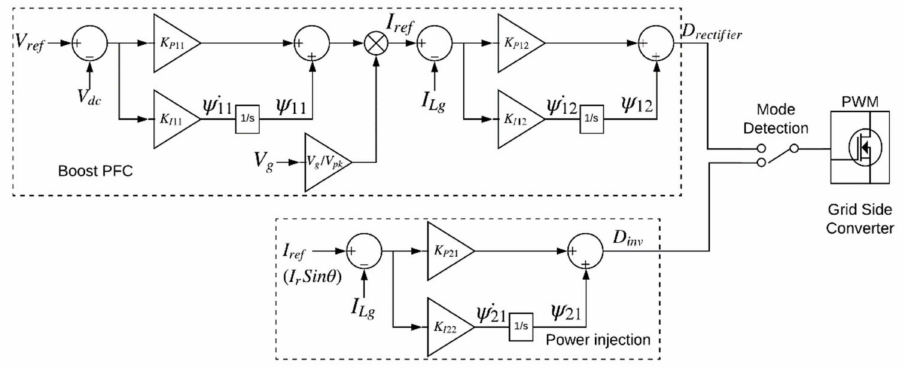
Figure 3. Controller block diagram for grid side